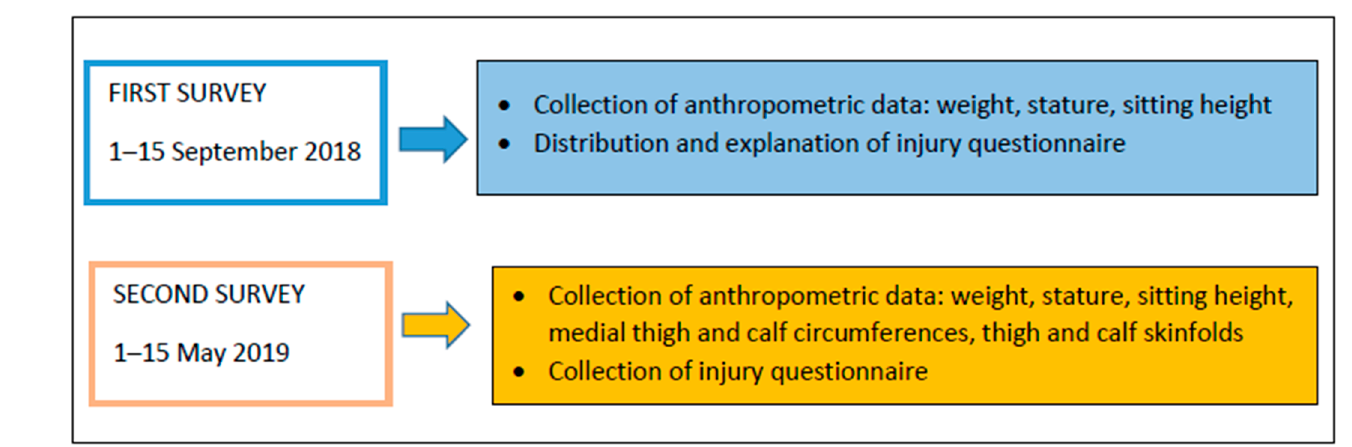
Figure 1. Schematic figure showing the experimental design of the study.